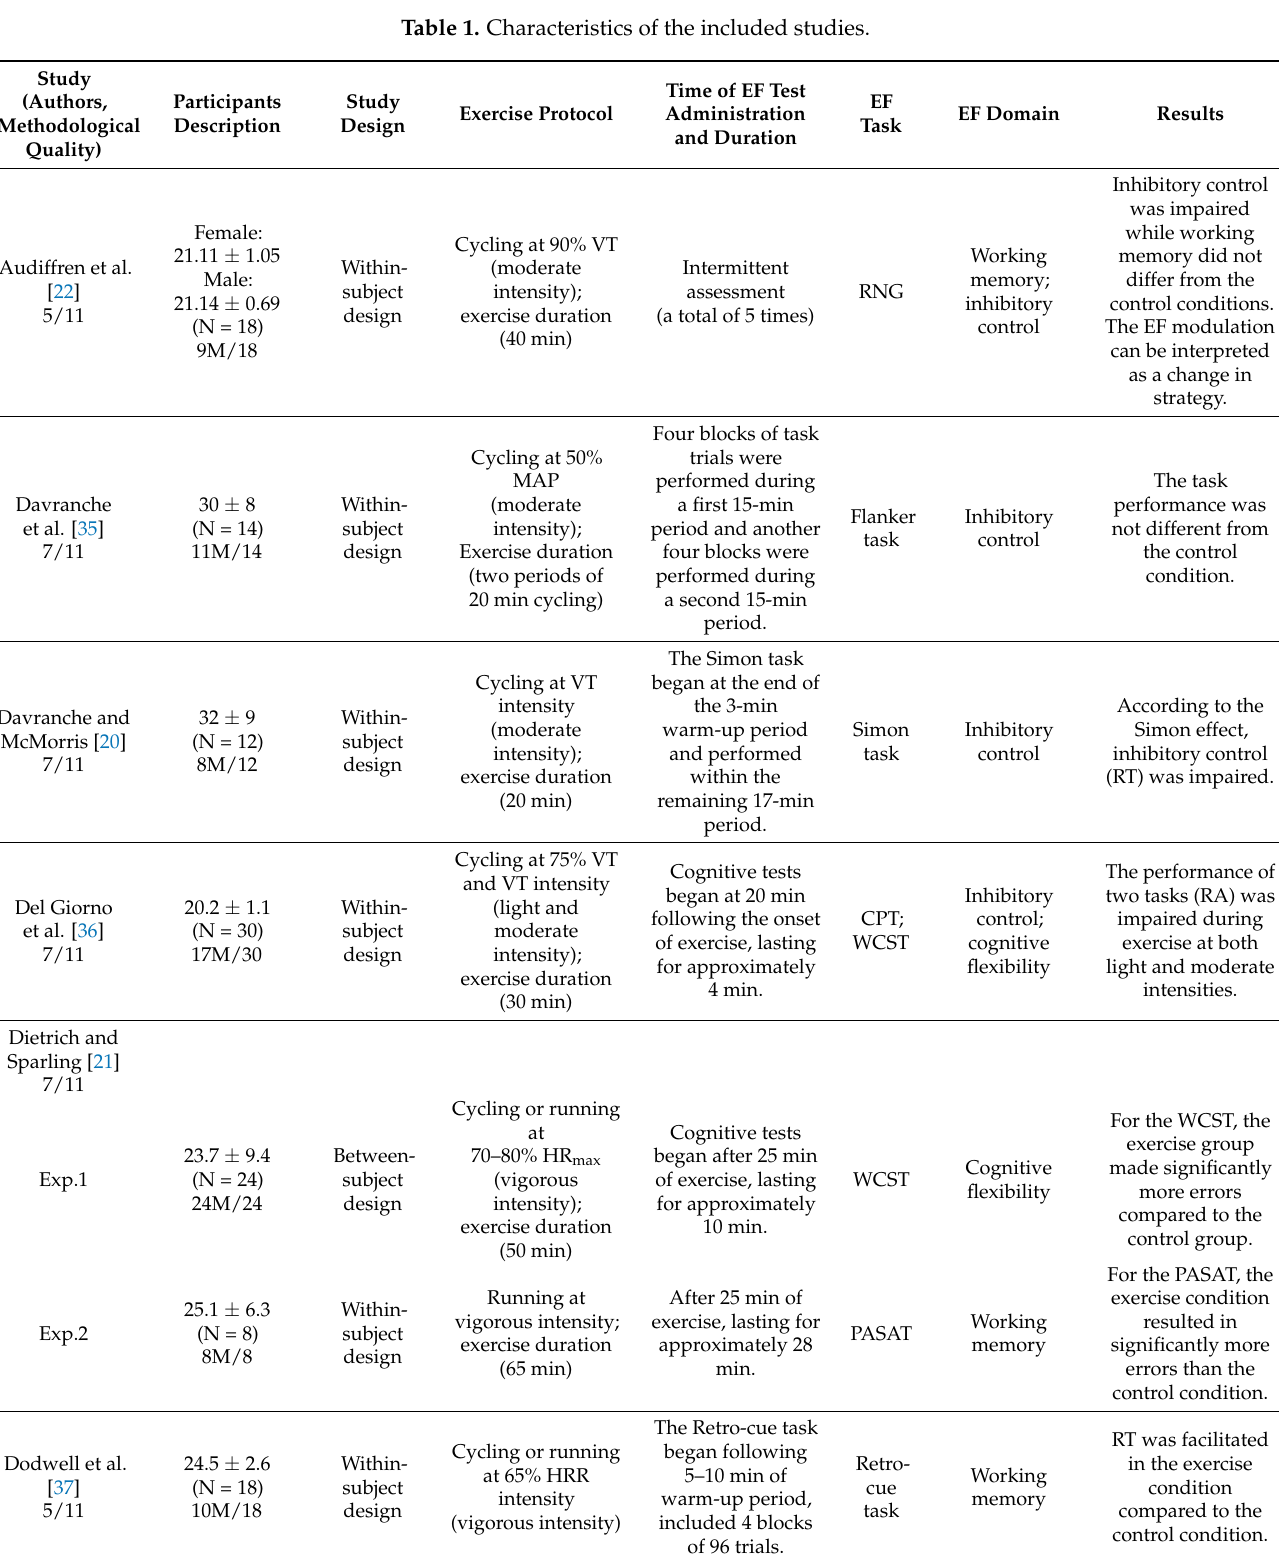
Table 1. Characteristics of the included